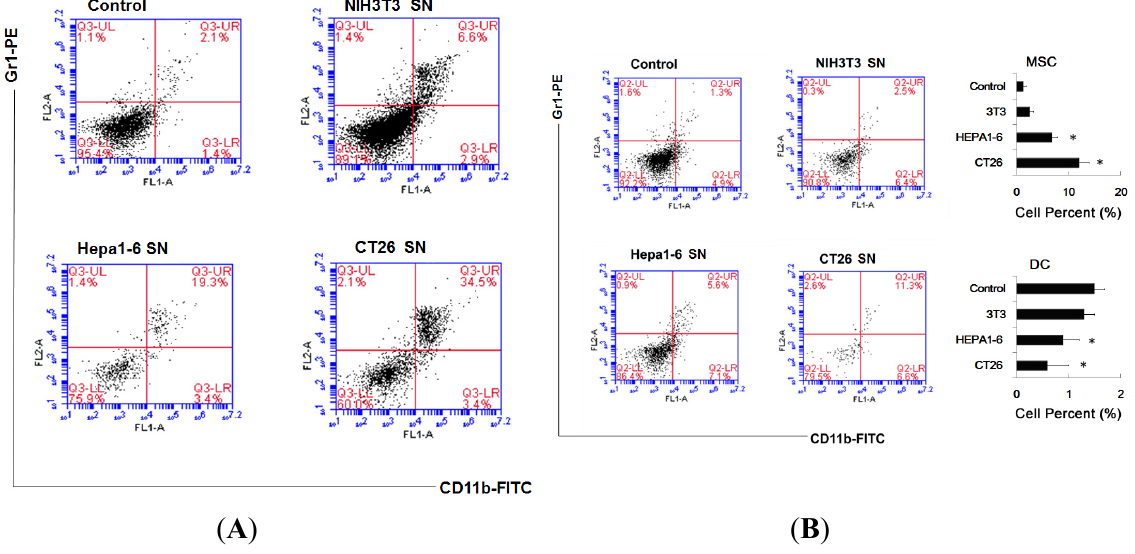
Figure 3. Twist regulated the effect of tumor cells of inducing myeloid precursor cells into MDSC. ( A ) Firstly, the relative mRNA expression of Twist of CT26, Hepa1-6 and NIH3T3 cells were assayed by real time PCR. Histograms represent the relative mRNA expression. Results were the mean ± SD of three independent assays. * p < 0.05; ( B ) CT26 cells were transfected with Twist siRNA (Twist S1, Twist S2, Twist S3 and Mock siRNA) as method indicated. Relative Twist mRNA expression was assayed by real time PCR. Results were the mean ± SD of three independent assays. * p < 0.05; ( C ) Hepa1-6 cells were transfected with Twist siRNA (Twist S1, Twist S2, Twist S3 and Mock siRNA) as method indicated. Relative Twist mRNA expression was assayed by real time PCR. Results were the mean ± SD of three independent assays. * p < 0.05; ( D ) NIH3T3 were transfected with Twist overexpression plasmid (pBABE-puro-mTwist), negative control plasmid (pBABE-puro) and blank control (No Plasmid). The relative Twist mRNA expression was then assayed by real time PCR. Results were the mean ± SD of three independent assays. * p < 0.05; ( E ) The supernatants of siRNA transfected CT26 cells were collected and co-cultured with myeloid precursor cells, and then these cells were purified for MDSC phenotype identification. The percent of Gr1 + CD11b + were 16.4% (Twist siRNA) and 34.0% (control siRNA) respectively; ( F ) After co-cultured with supernatants, these cells were labeled with Ab to CD80 and CD86, and assayed by FACS respectively. Results were the mean ± SD of three independent assays. * p < 0.05; ( G ) CD4 + T cells from